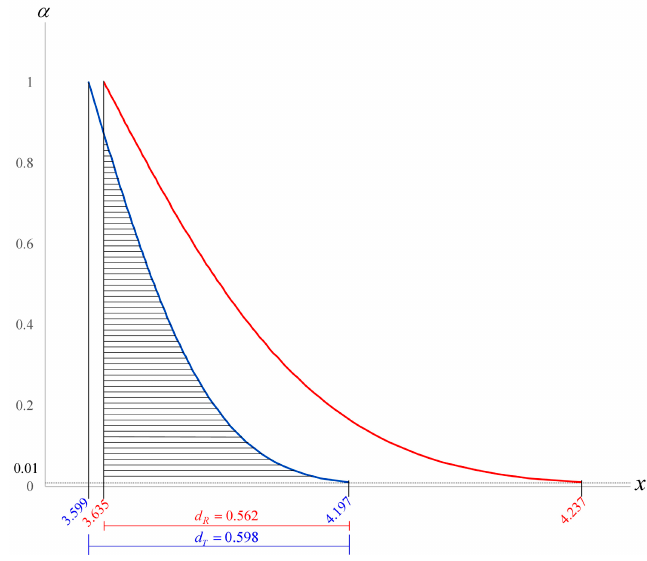
Figure 3 is a diagram of membership function and